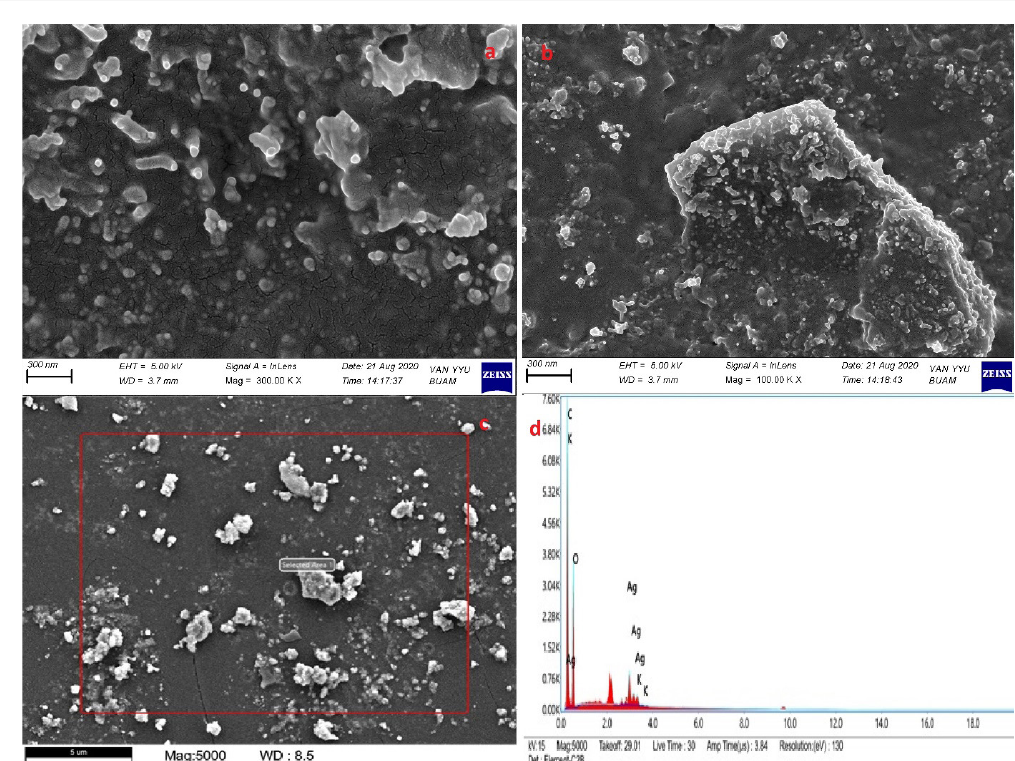
FIGURE 1 - (a-c) SEM images in different scale and corresponding (d) SEM-EDX spectrum of Ag NPs/Sa.